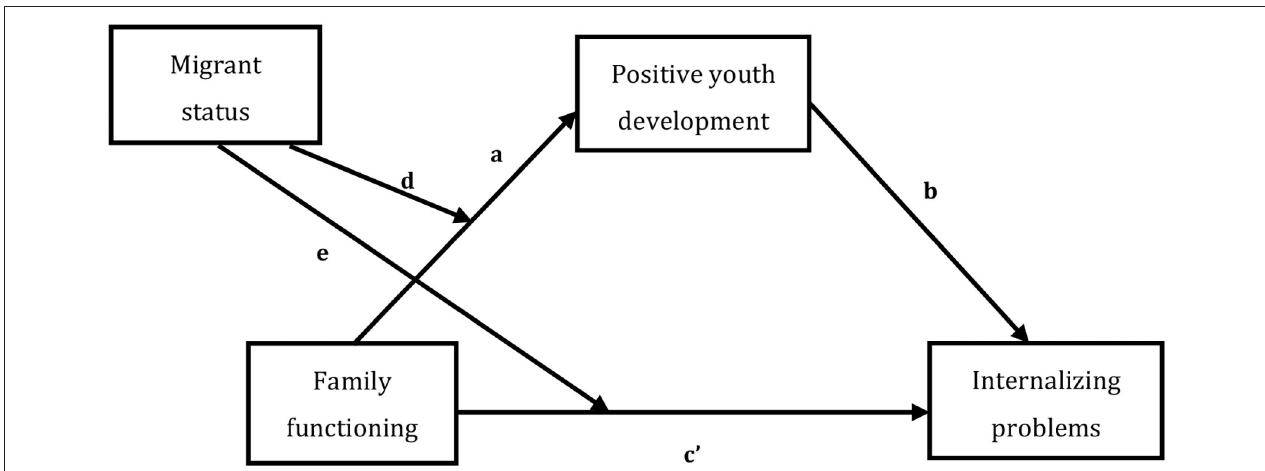
FIGURE 1 | The moderated mediation model. a = the relation between family functioning and positive youth development; b = the relation between positive youth development and internalizing problems; c ′ = the relation between family functioning and internalizing problems; d = the moderating effect of migrant/local-born adolescents on the relation between family functioning and positive youth development. e = the moderating effect of migrant/local-born adolescents on the relation between family functioning and internalizing problems.